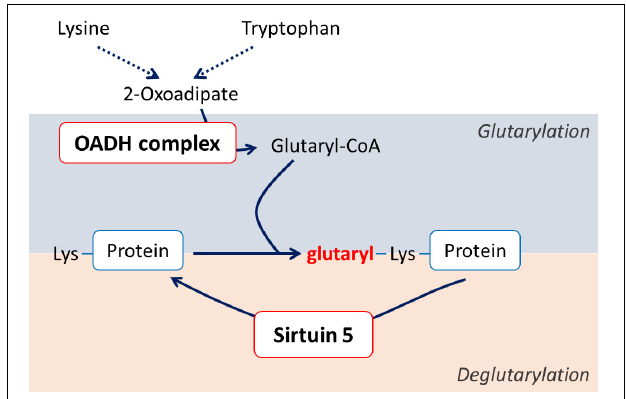
FIGURE 1 | Schematic view of the association between the OADH-catalyzed reaction and protein glutarylation.